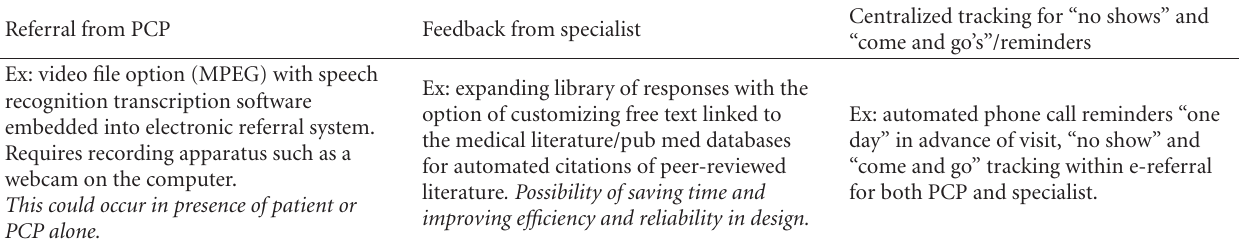
Table 1: Increased collaboration between the PCP and